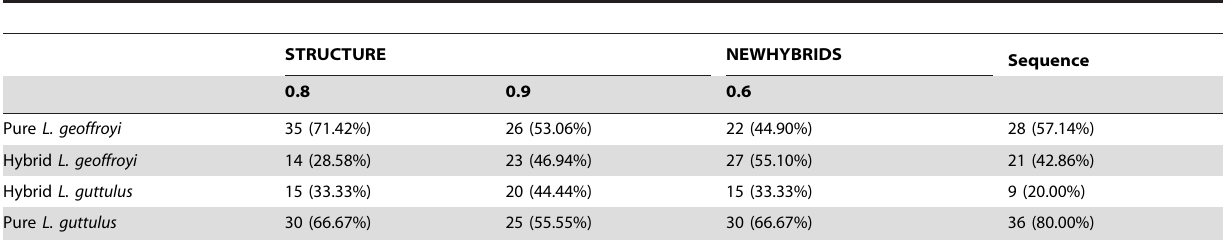
Table 3. Absolute number and percentage of identified hybrid and pure individuals in the Rio Grande do Sul (RS) sample under the thresholds established for each of the microsatellite analyses (0.8/0.9 for STRUCTURE, and 0.6 for